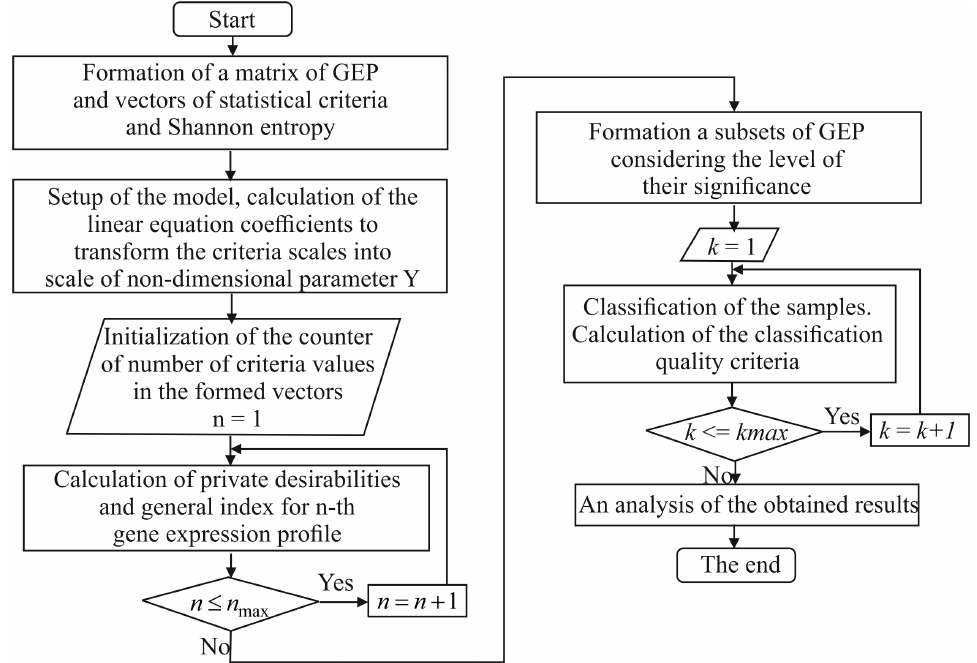
Figure 3. Structural block chart of the algorithm that forms the subsets of informative GEPs based on Harrington’s desirability function and assessment of the model